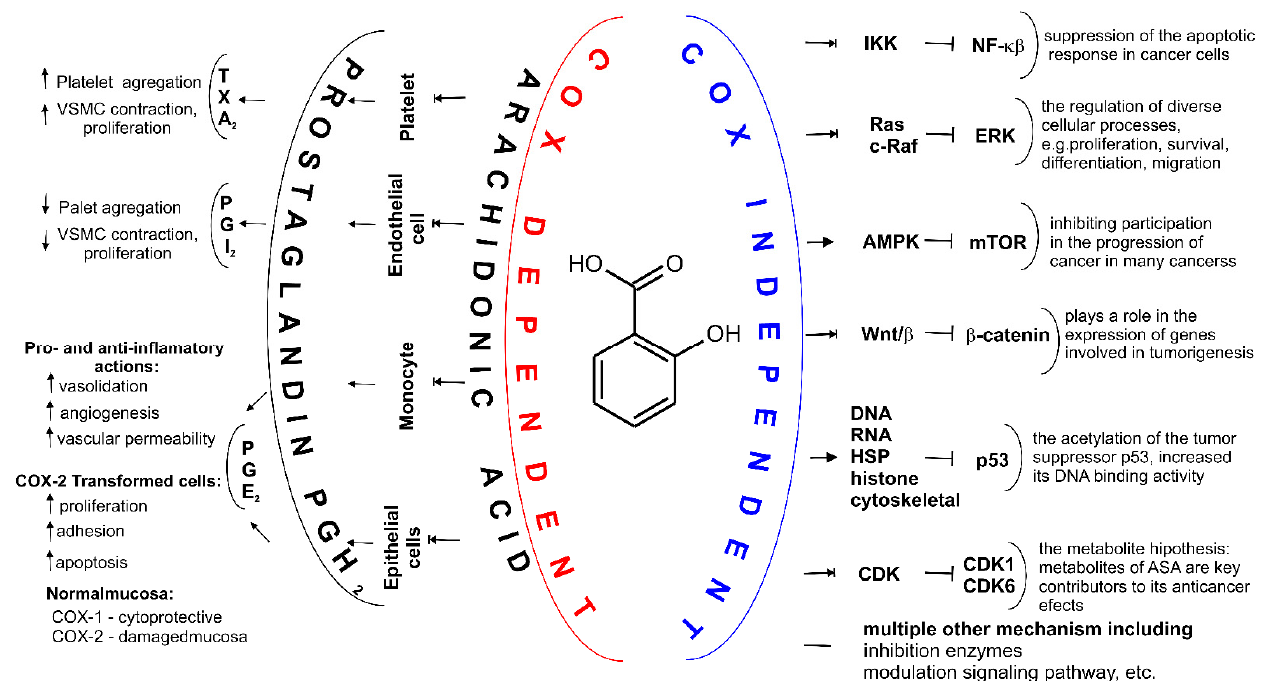
Figure 4. Two major mechanisms of action for ASA. Depending on the cell type COX-dependent mechanism affects synthesis of different prostaglandins (PGs) including PGH 2 , PGE2, PGF2 α , prosta- cyclin PGI2 and tromboxane A2 (TXA2). Through various COX-independent mechanisms, ASA may modulate carcinogenesis and alter growth rate of the intestinal tumor. These pathways, including inhibition of nuclear factor (NF)- κ B signaling and the extracellular signal-regulated kinase (ERK) signaling, cells and may arrest cell growth by inhibiting cyclin dependent kinase CDKs, inhibition of the Wing-like glycoproteins, i.e., Wnt signaling, β -Catenin phosphorylation, activation adenosine monophosphate activated protein kinase (AMPK), decreasing mechanistic target of ra- pamycin (mTOR) signaling, acetylation many proteins such as histones, cytoskeletal and heat shock proteins (HSP), glycolytic and pentose pathway enzymes, proteasomal subunits and mitochondrial proteins, proteins involved in translation, wild-type and mutant a tumor suppressor protein (p53), and multiple other mechanisms, e.g., inhibition hydroperoxy fatty acid peroxidase in the lipoxygen- ase pathway of arachidonic acid metabolism.